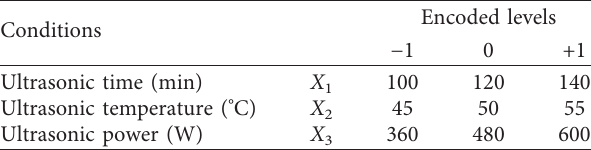
Table 1: Investigated levels of extraction